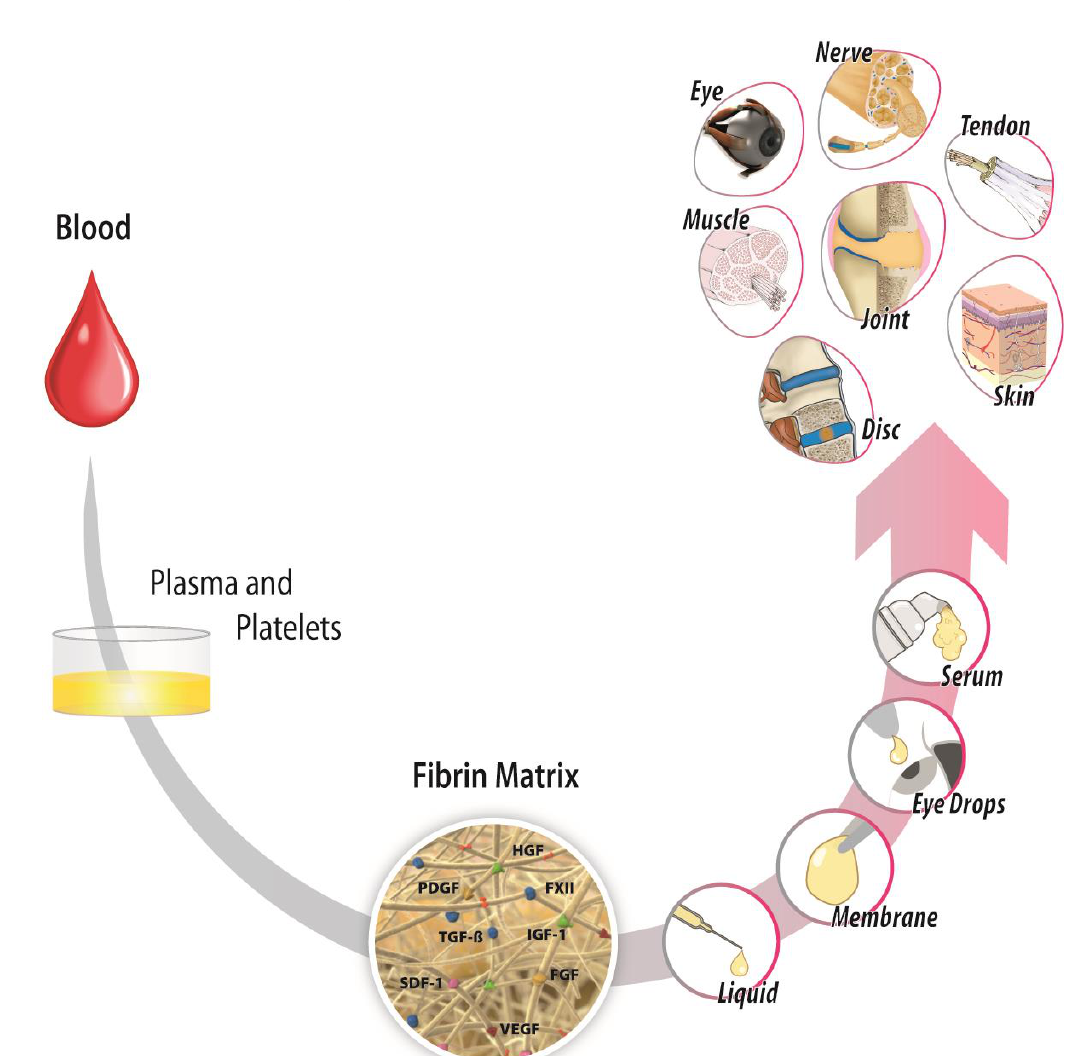
Figure 4. Autologous fibrin matrix (AFM) is a by-product of nature’s own healing systems that in- volves blood anticoagulation and mild centrifugation steps followed for fibrin formation by restoring thrombin production. The injected AFM into the damaged tissue operates as a liquid-to-gel dynamic scaffold that carries plasma- and platelet-derived growth factors, including TGF- β 1, PDGF, VEGF, HGF, FXII, or IGF-1, as biological mediators for tissue repair. The gradual biodegradation of a fibrin clot mediated by the serine protease plasmin will release GFs that act as extracellular ligands by binding to transmembrane receptors on the surface of target cells, thereby activating intracellular signal transduction pathways to induce a wide range of cell specifications during inflammation and the healing process: cell survival, proliferation, migration, differentiation, transdifferentiation, maturation, and changes in protein synthesis and metabolism. These biologics are emerging as a promising therapeutic approach with antialgic, anti-inflammatory, trophic, antifibrotic, and tissue- specific angiogenesis effects. They are applied in sterile-inflammatory injuries such as osteoarthritis, tendinopathies, cartilage injuries, peripheral neuropathies, intervertebral disc degeneration, skin burns and ulcers, corneal ulcers, and dry eyes, among other